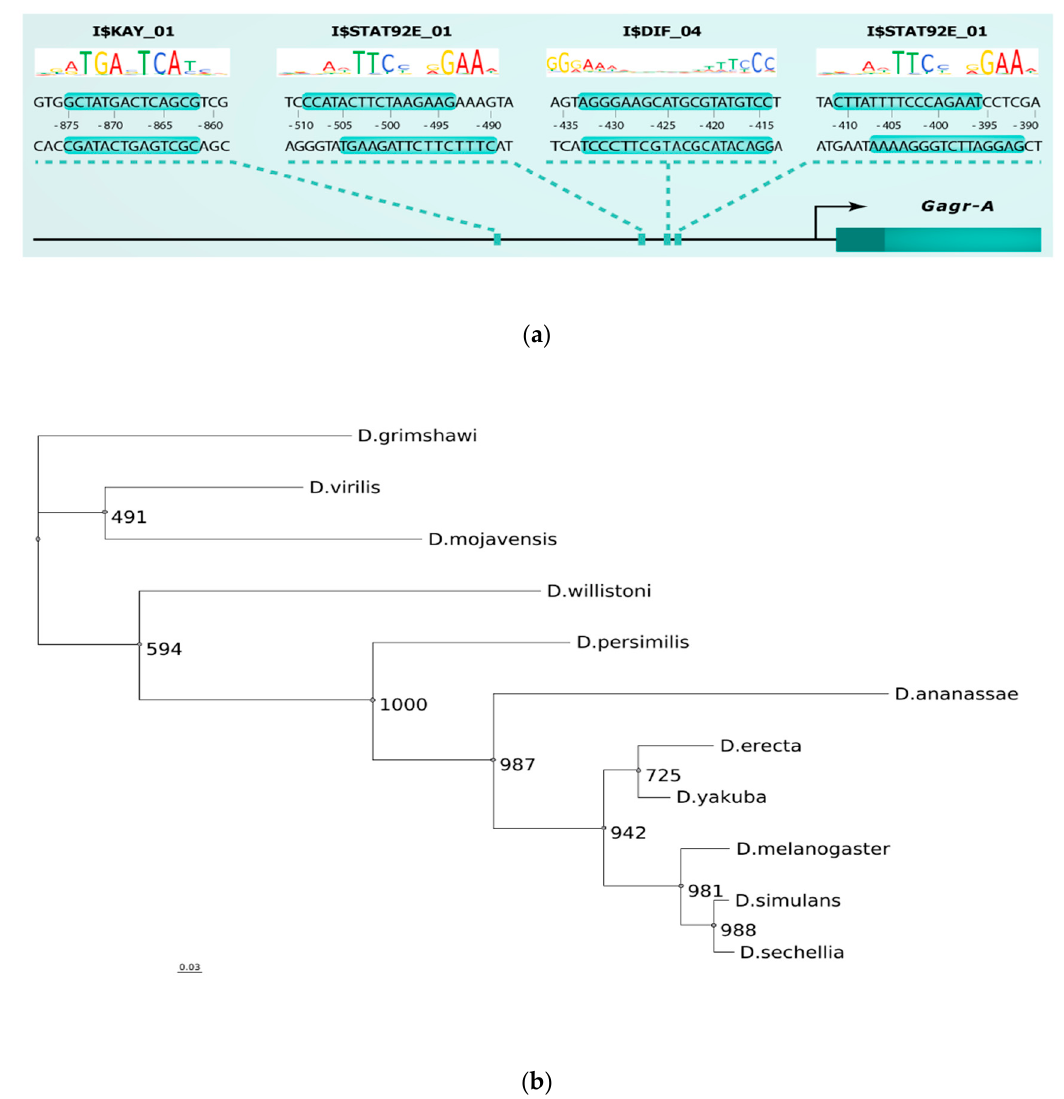
Figure 7. Analysis of the promoter regions of the Gagr gene and its orthologs. ( A ) Localization of binding sites for the transcription factors Dif, kay and Stat92E in the Gagr gene promoter. ( B ) Phylogram based on the promoter sequences of the Drosophila Gagr gene; bootstrap branch values are presented (the number of bootstrap replicas is 1,000).